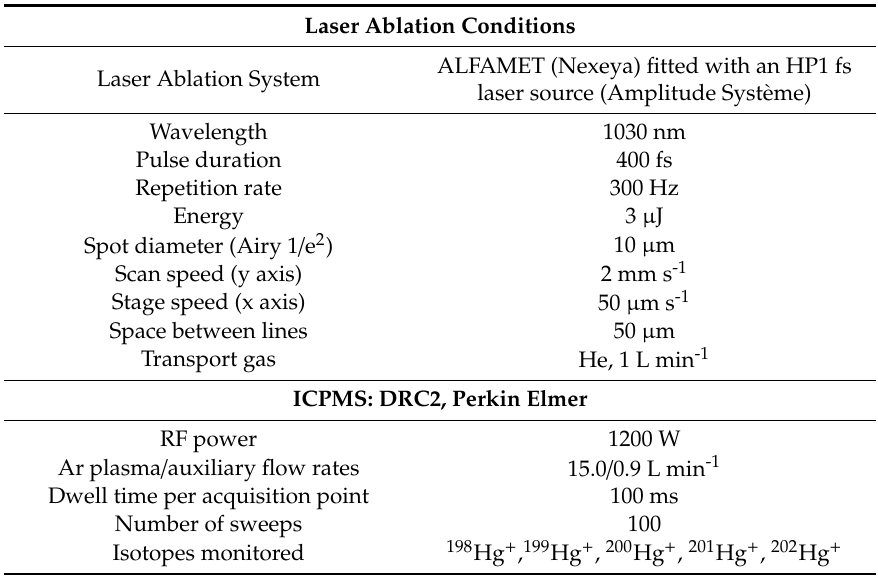
Table 1. Instrumental operating conditions used for glass eel slices laser ablation coupled to inductively coupled plasma mass spectrometry (LA-ICPMS)